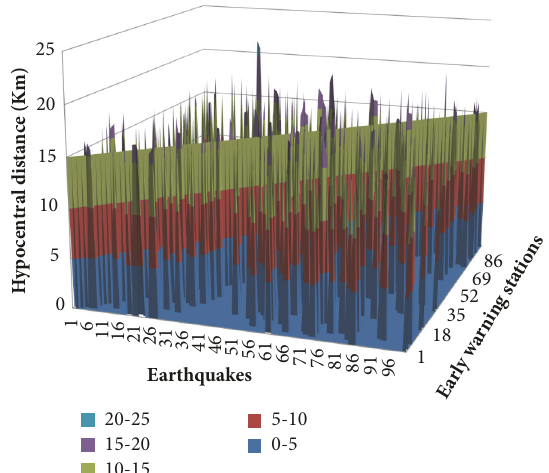
Figure 4: List of 100 earthquakes (EQ) with distribution of four nearest stations and their corresponding hypocentral distance (km).